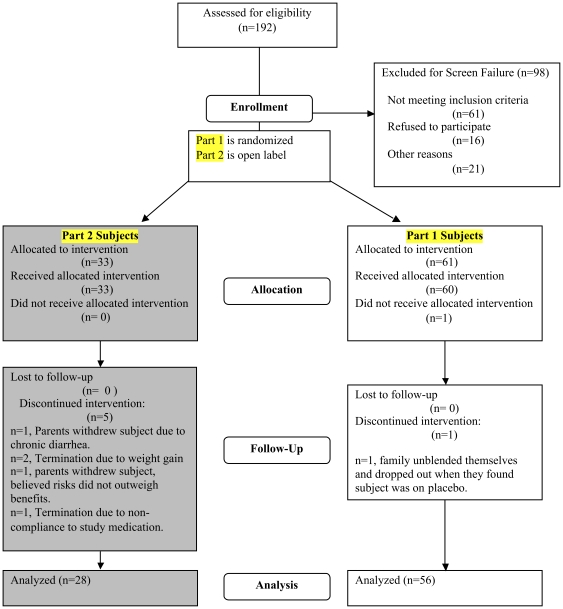
Consort flow sheet.